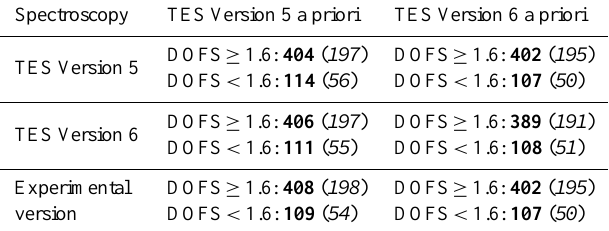
Table 2. Number of TES (bold) and HIPPO (italic) scans matched for each combination of spectroscopy, a priori, and corrections. Val- ues are given for scans with DOFS ≥ 1.6 and DOFS <